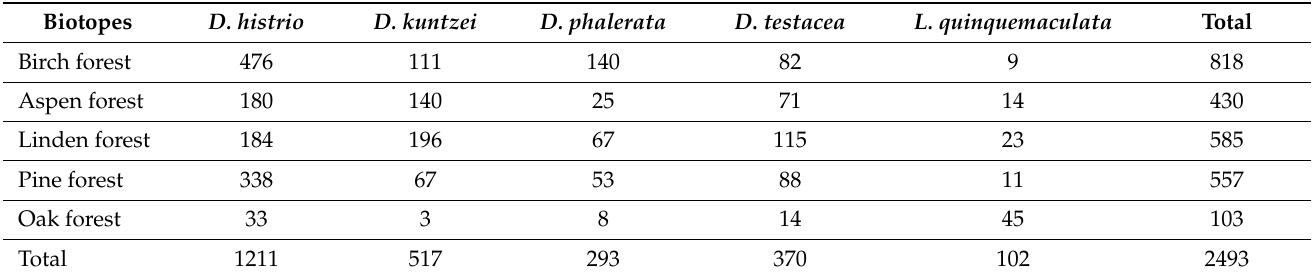
Table 4. Total collected specimens of mycetobiont drosophilid species in five biotopes.